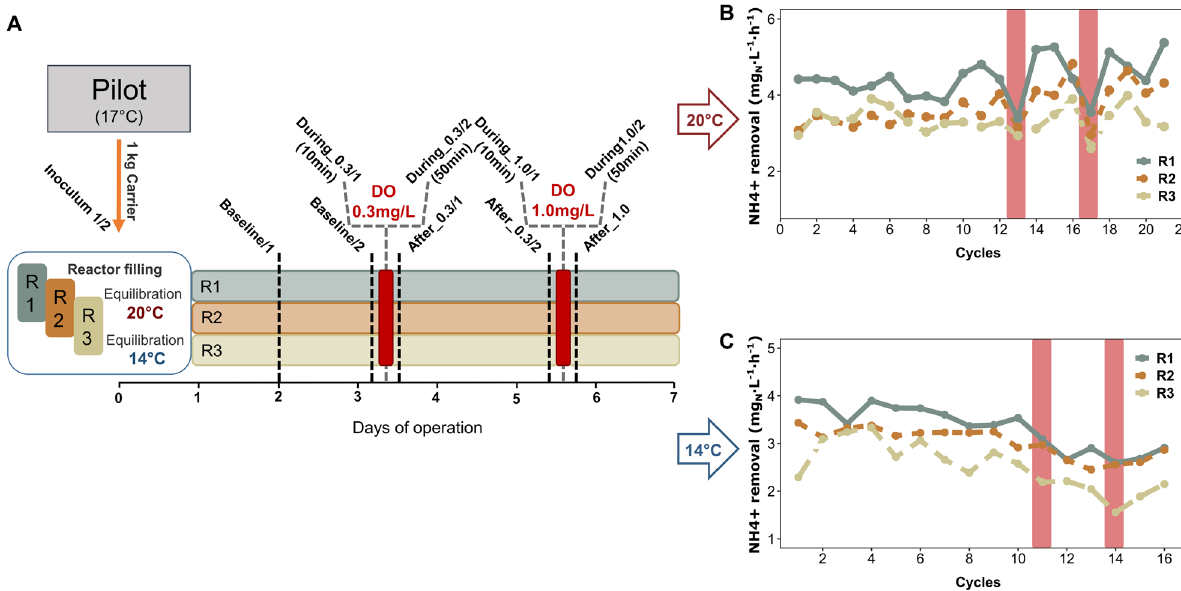
Fig. 1 Sampling scheme and average NH 4 + removal rate. A Experimental setup and carrier sampling scheme with sample names. B Average NH 4 + removal per SBR cycle in mg Nitrogen/Liter/hour during the 20 °C experiment. Colors of the linecharts denote the different reactors (green: Reactor1; brown: Reactor2; beige: Reactor3). Red bars highlight the DO disturbed cycles. C Average NH 4 + removal per SBR cycle mg Nitrogen/Liter/Hour during the 14 °C experiment. Colors of the lines denote the different reactors. Red bars highlight the DO disturbed cycles.